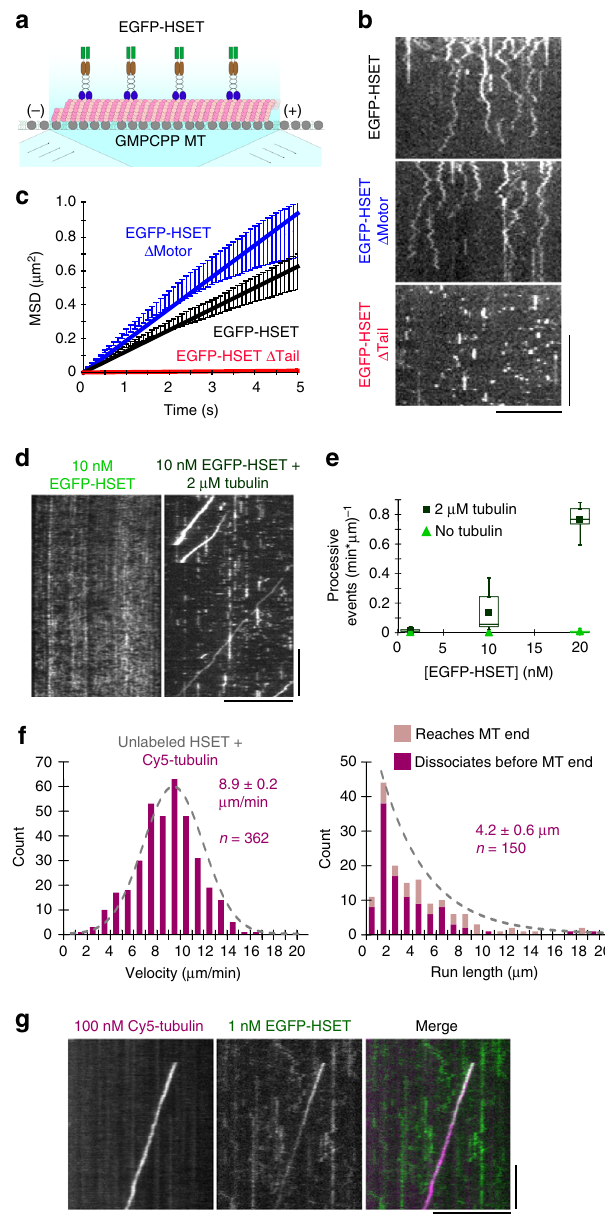
soluble (non-MT) tubulin binds the HSET tail domain directly.